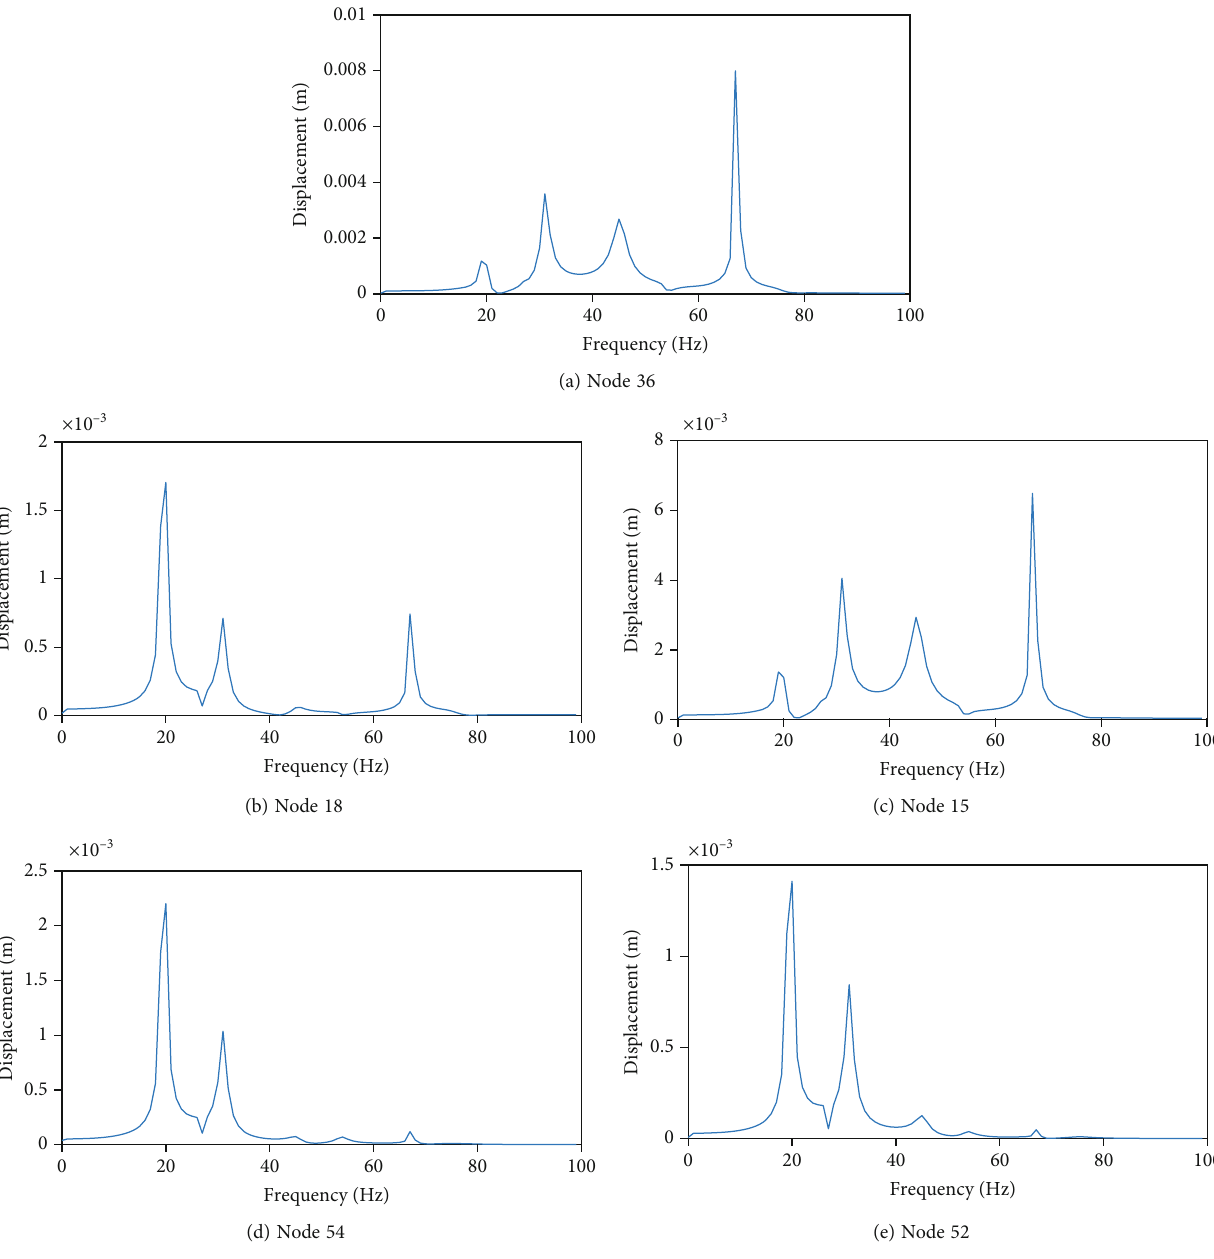
Figure 13: Response frequency analysis at key points in path